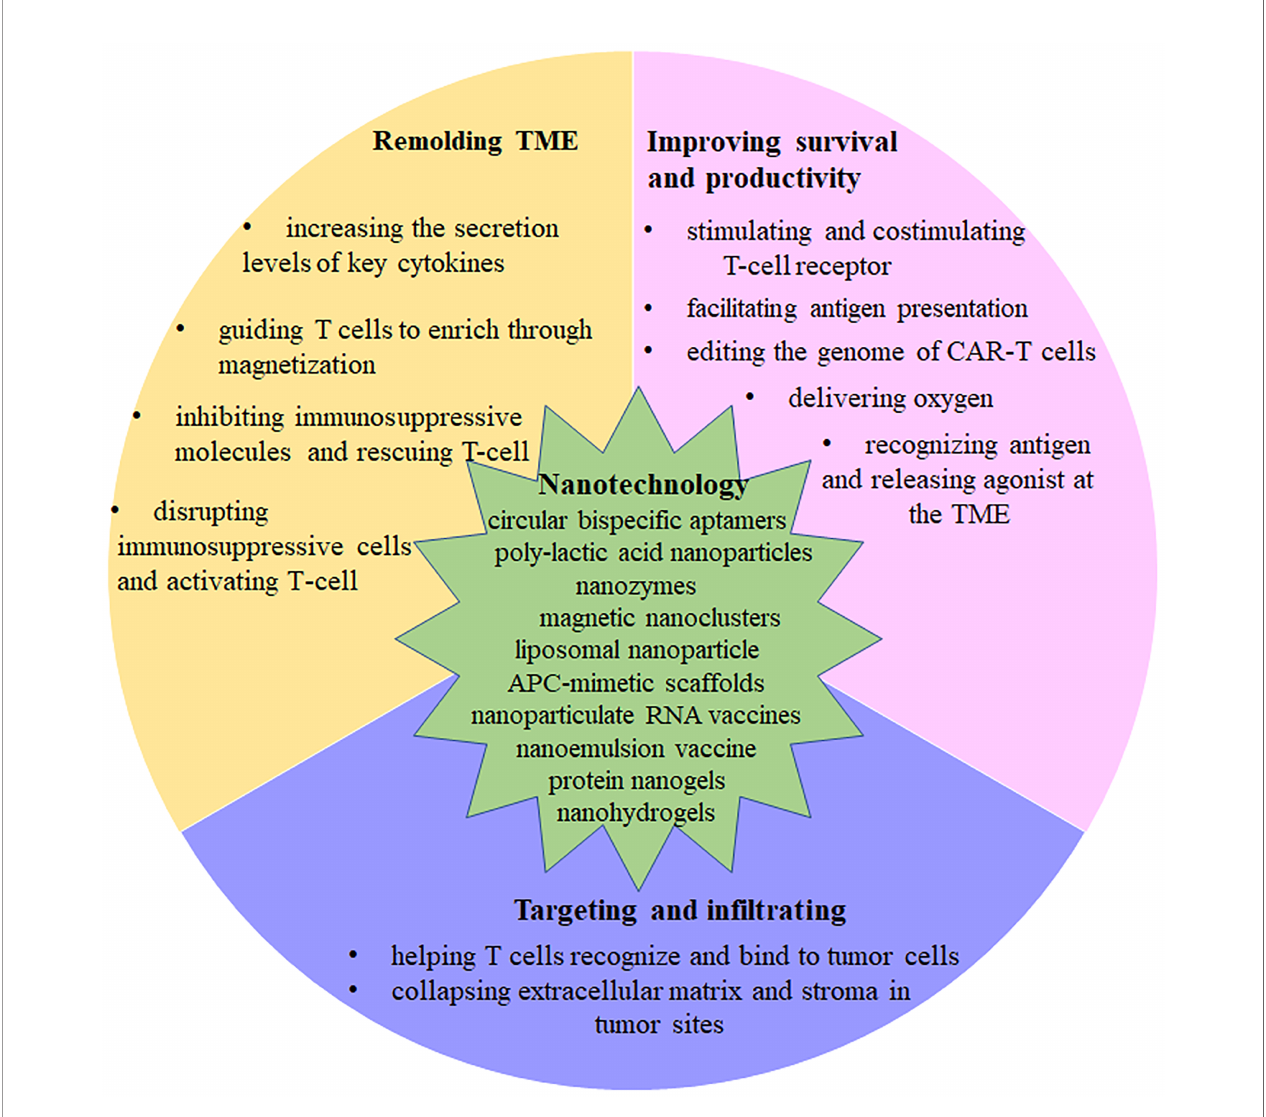
FIGURE 1 | The mechanisms of Nanotechnology affect CAR-T function. Summary of strategies that are discussed in detail in this